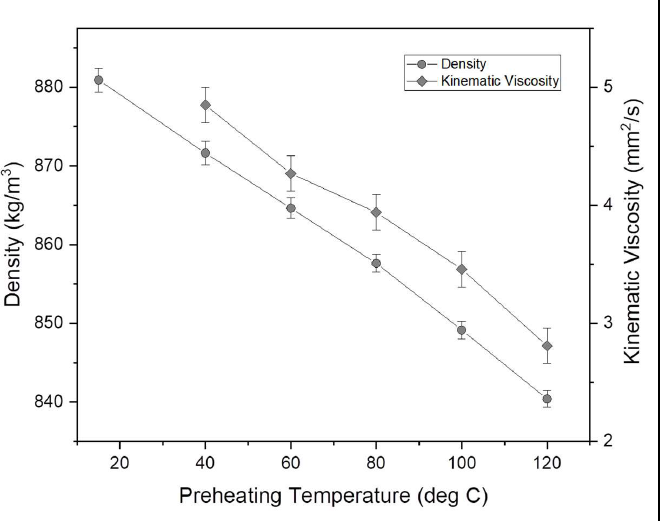
Figure 5. Variation in density and kinematic viscosity of WAF-O biodiesel at varying